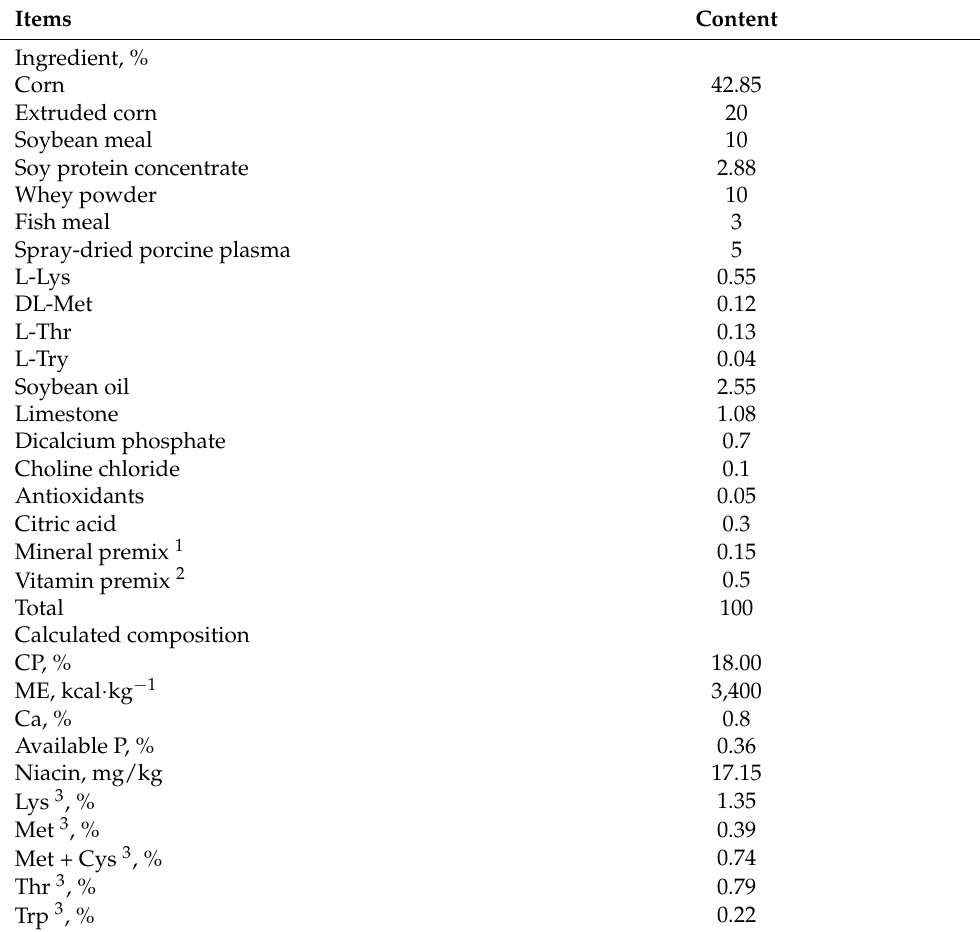
Table 1. Ingredient and chemical composition of piglet diets, as fed